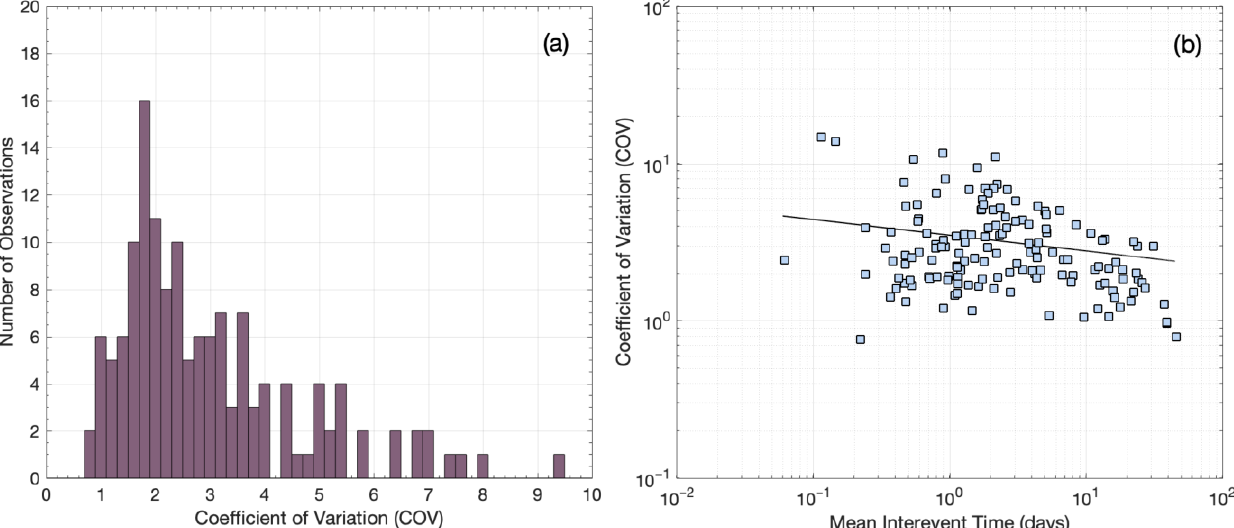
Figure 12. ( a ) Histogram of coefficient of variation (COV) values for the multiplet families with N ≥ 10. ( b ) The COV values as a function of the mean inter-event time (in days) for each multiplet family with N ≥ 10. The solid line shows an inverse power law function with slope – 0.1.